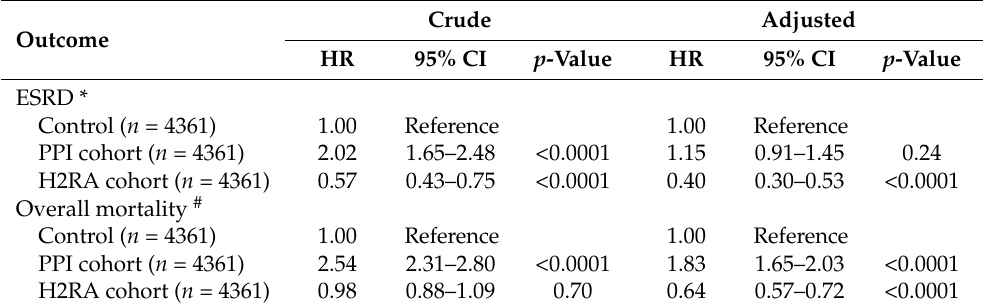
Table 2. Hazard ratios (HRs) for end-stage renal disease (ESRD) and overall mortality in three